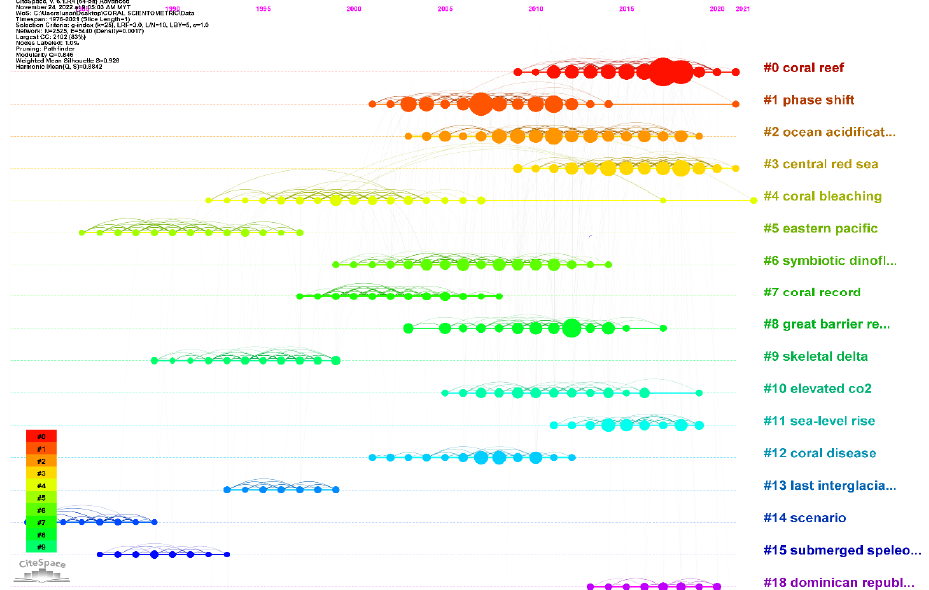
Figure 8. A timeline co ‐ citation analysis. Nodes represent references, whereas lines represent con ‐ nections between those references. Larger nodes indicate higher frequencies of citations. References with strong citation bursts are shown as red circles, whereas references with high centrality are shown as yellow circles. Longer line segments indicate longer time spans.